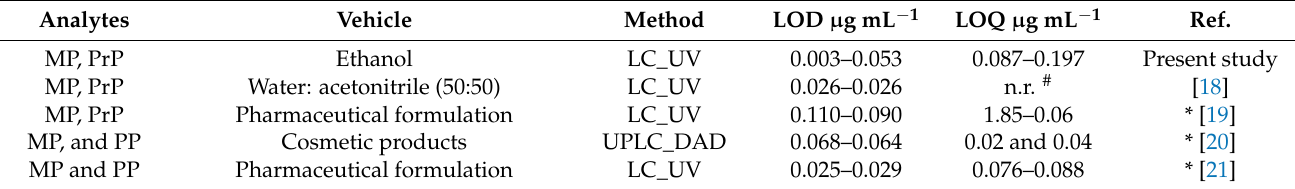
Table 3. Comparison of present study with the literature’s analytical methods for the estimation of MP, PrP LOD values. * PBs along with compounds of other chemical classes. # not